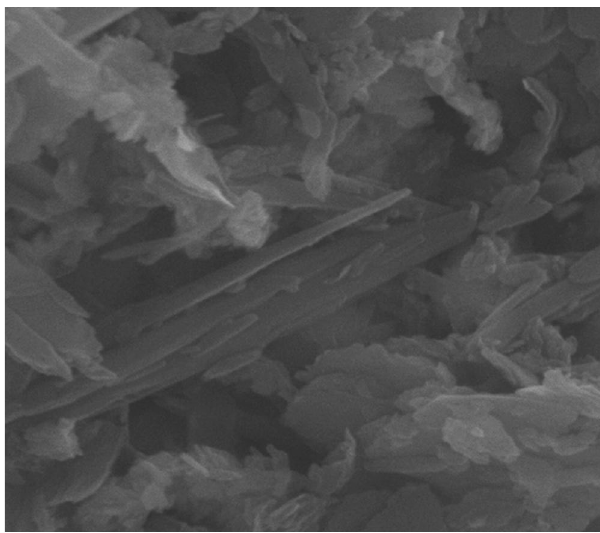
Figure 8. SEM image of the recycled catalyst after six reaction